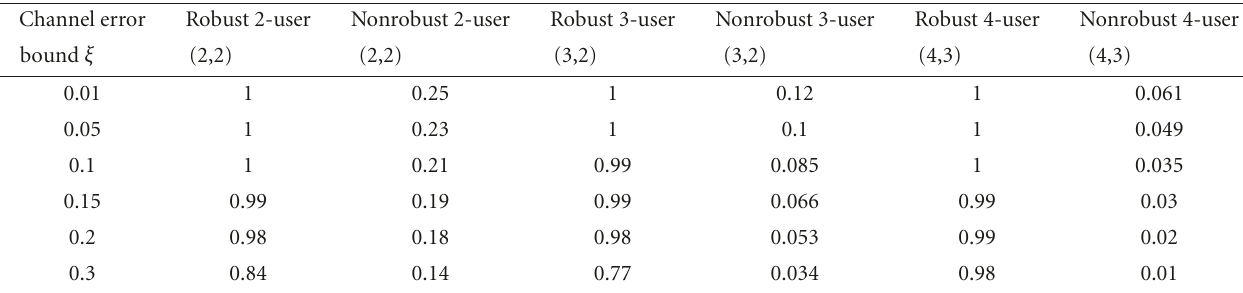
Table 2: Service probabilities for multiuser MIMO systems where both imperfect CSIT and imperfect CSIR are considered such that ξ ( m ) T = ξ for all m , ξ ( m ) R = ξ (cid:14) for all m and ξ = 2 ξ (cid:14) .